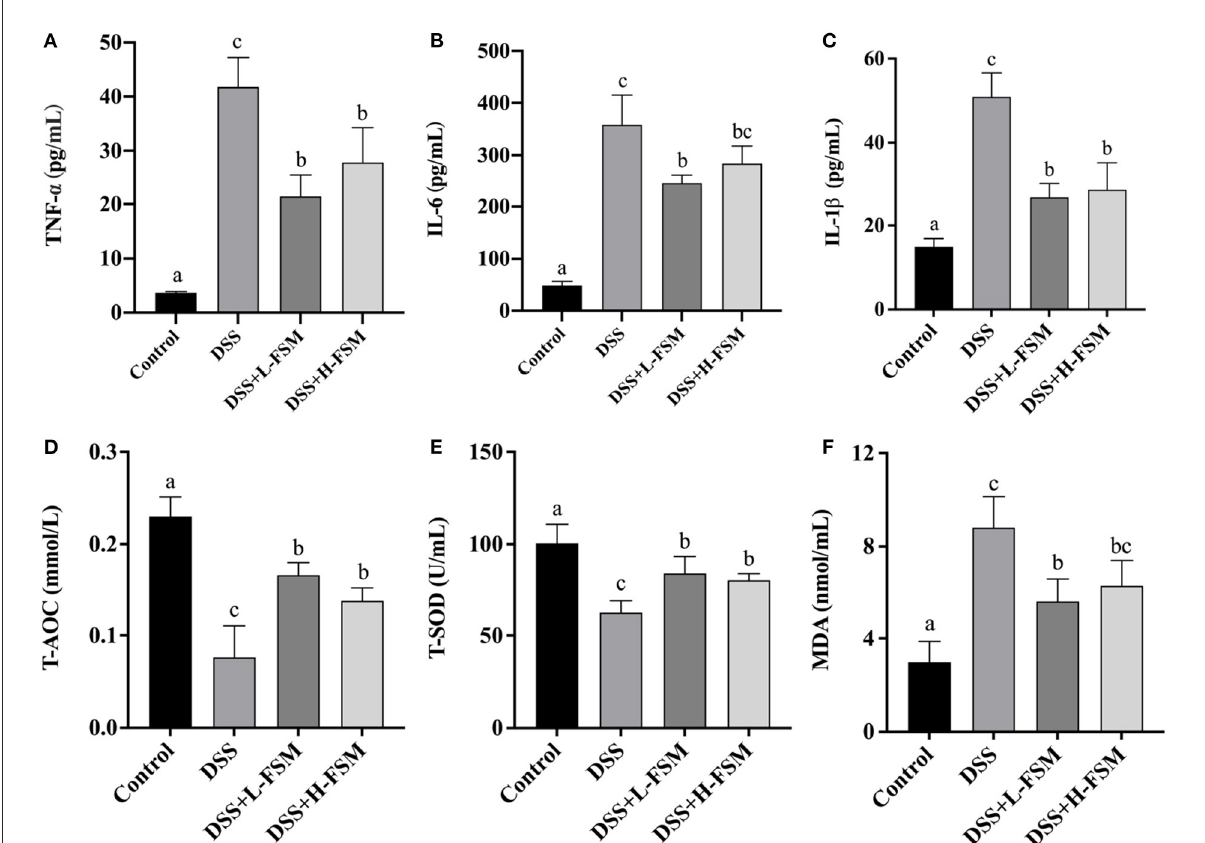
FIGURE7 Effect of fermented soymilk on the release of blood inflammatory cytokines in mice with DSS-induced colitis. Concentrations of three pro-inflammatory cytokines, Tumor necrosis factor- α (TNF- α ) (A) , interleukin-6 (IL-6) (B) , interleukin-1 β (IL-1 β ) (C) in the serum ( n = 6 per group). Concentrations of T-AOC (D) , T-SOD (E) , MDA (F) in the serum ( n = 6 per group). (a–d) Different letters indicate significant differences between groups according to Tukey’s HSD test ( p <